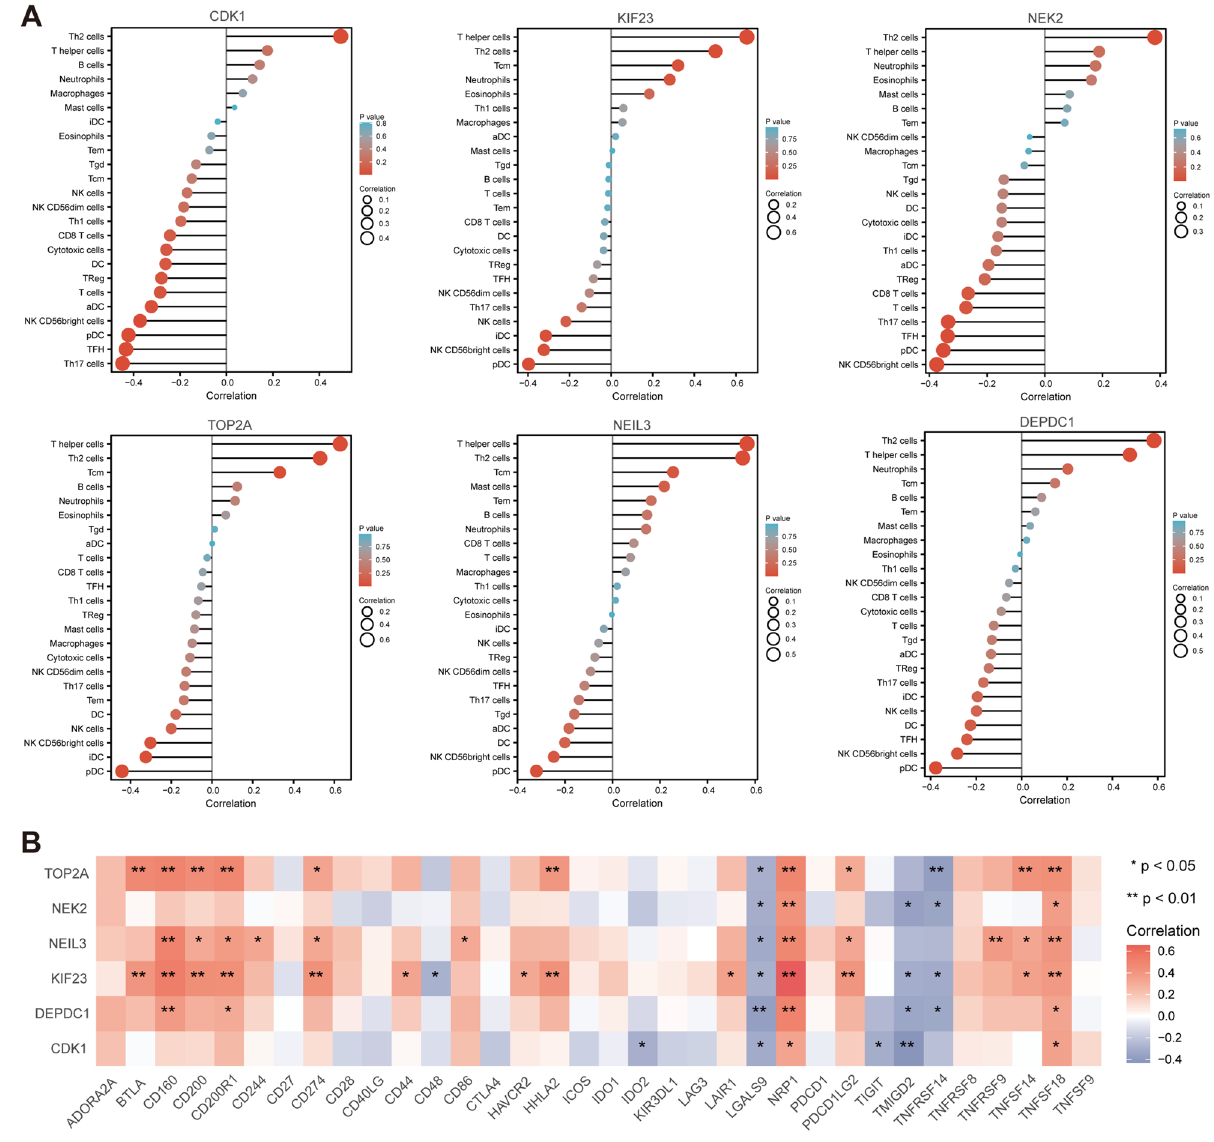
Figure 10. Immune landscape assessment. ( A ) Relationship of hub genes expression and immune cell subtypes in DLBCL patients. ( B ) Heatmap of the correlation between hub genes expression and immune checkpoint. *P < 0.05, **P < 0.01, and ***P < 0.001.